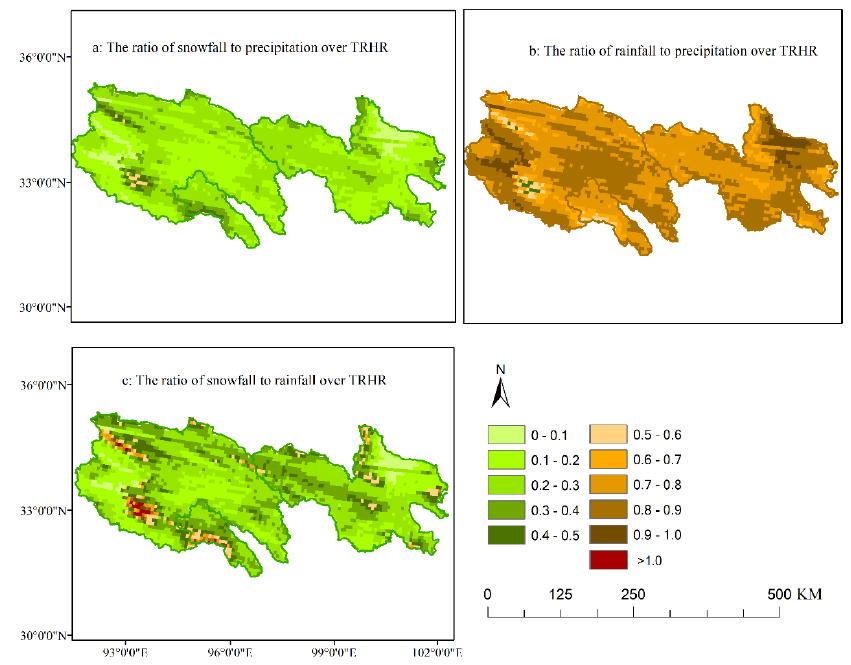
Figure 4. Spatial distribution of ( a ) ratio of snowfall to precipitation; ( b ) ratio of rainfall to precipitation; ( c ) ratio of snowfall to rainfall from 1971 to 2007 across TRHR.